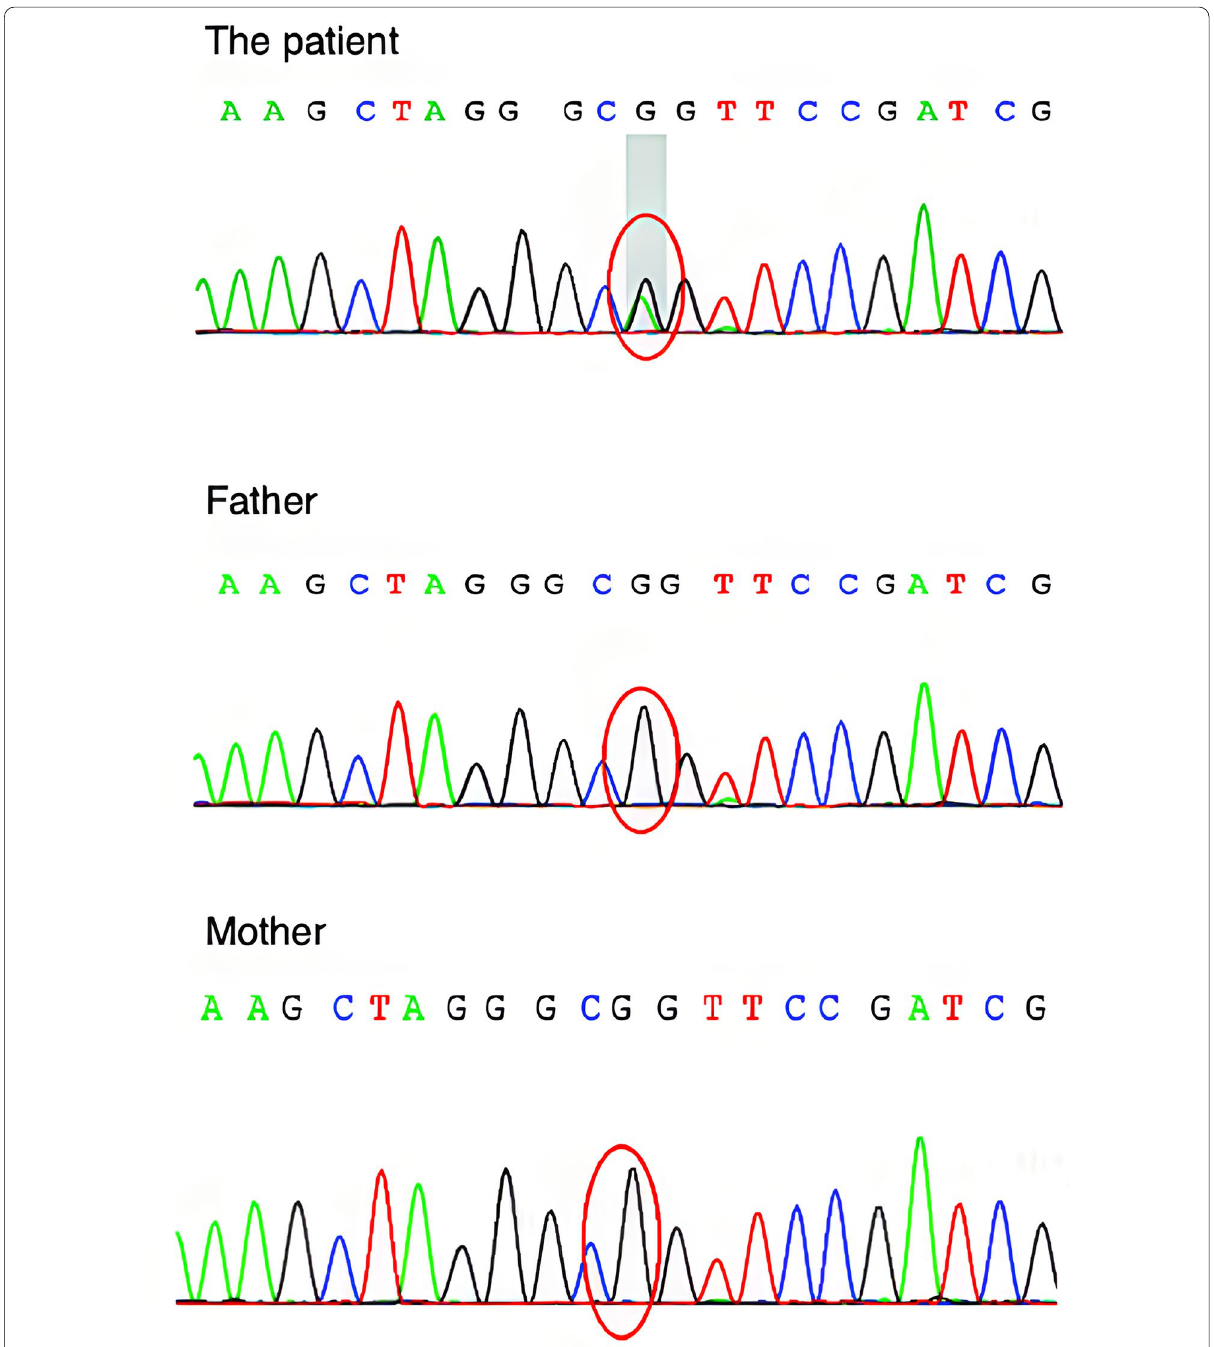
Fig. 4 Genetic analysis results of the child with West syndrome and his parents. A novel heterozygous variant (c.244C > T chr1, 111,147,161,p.R82C) in the KCNA2 gene (NM_004974.3) was detected in the child. No mutation in the KCNA2 gene was detected in his